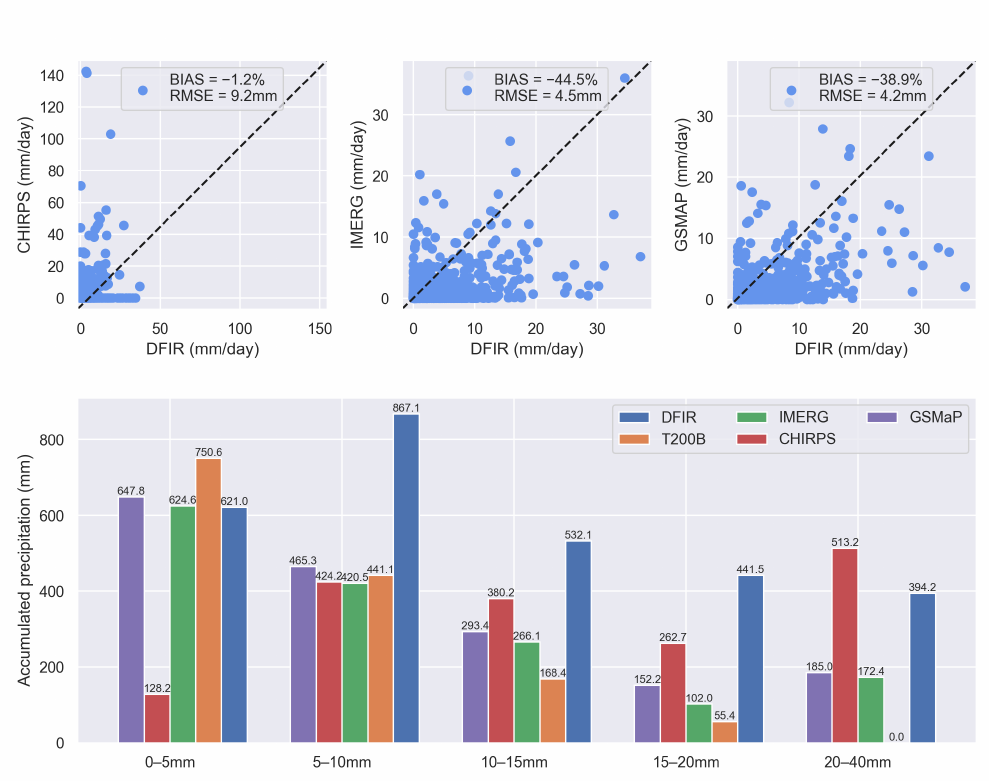
Figure 4. The comparison among remotely sensed precipitations and in situ DFIR observations. The upper subfigures are the scatter plots between the DFIR and the remotely sensed precipitations (CHIRPS, IMERG, and GSMaP). The lower bar graph compares precipitation datasets in different daily precipitation ranges from 0–5 mm/day to 20–40 mm/day. The precipitation values are labeled above each